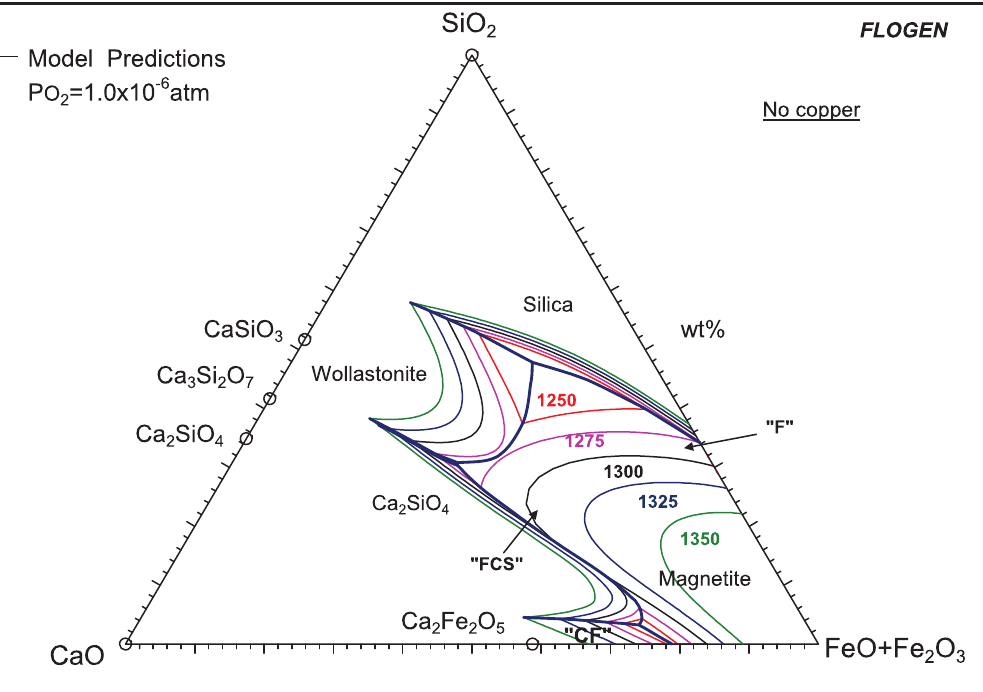
D 10 (cid:3) 6 atm show- 2